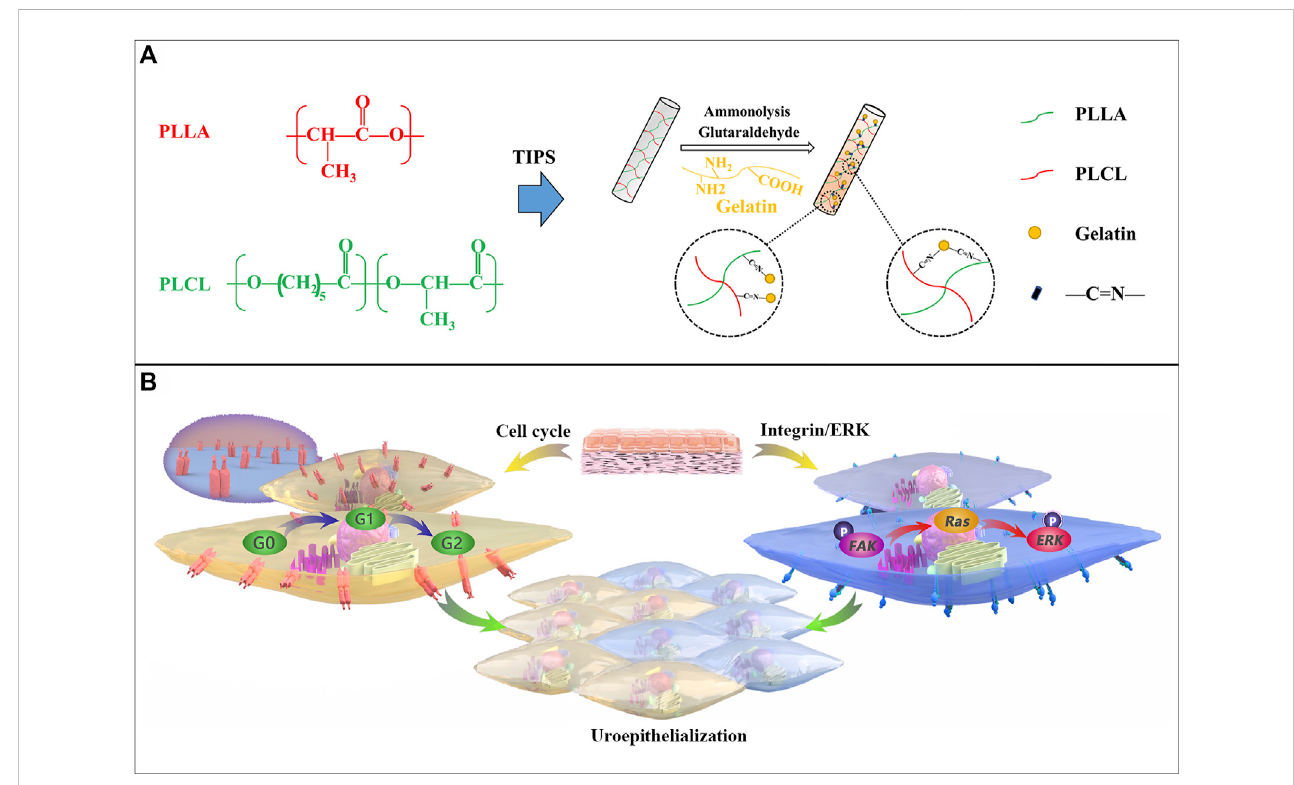
FIGURE 1 Procedure of PP-gel scaffold fabrication and the biomechanism of urothelialization. (A) Schematic illustration of the preparation of PLLA/PLCL scaffolds with grafted gelatin. (B) Biological mechanism of the PP-gel scaffold promoting urothelialization.